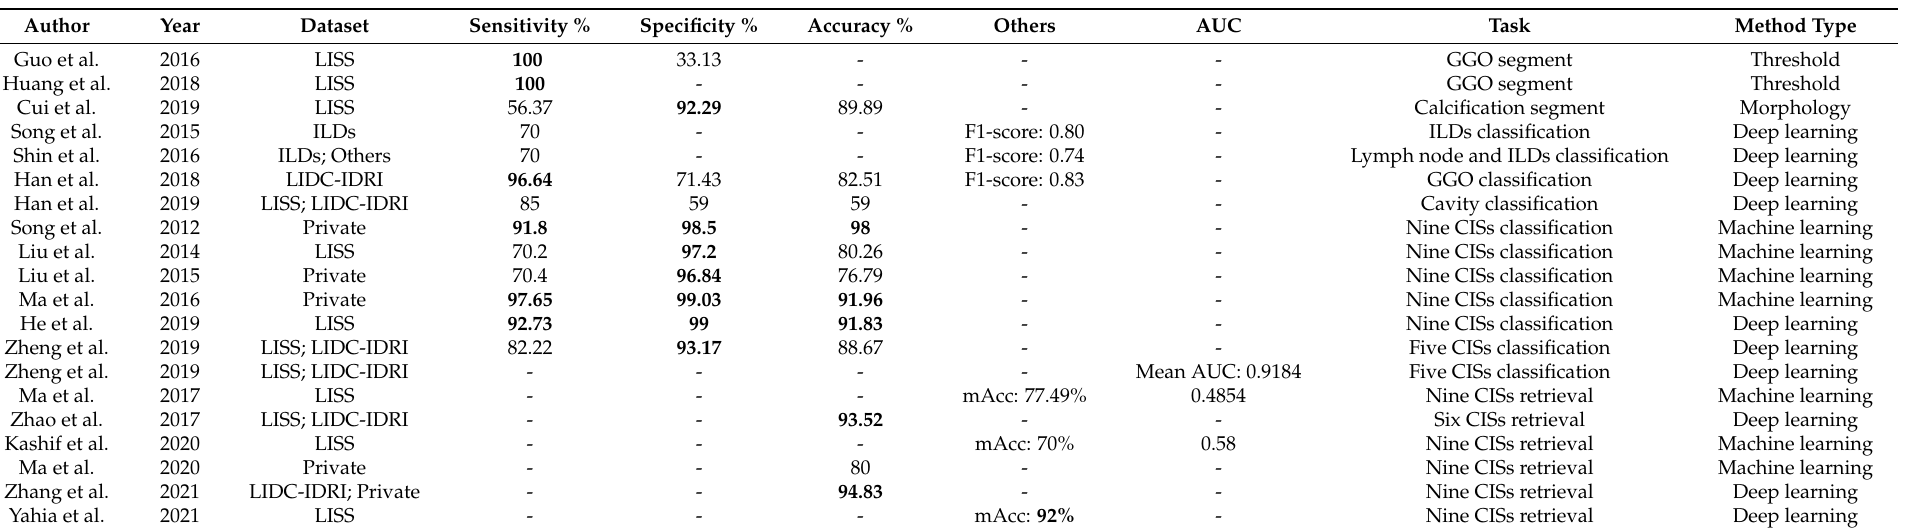
Table 3. The performance comparison of detection methods for